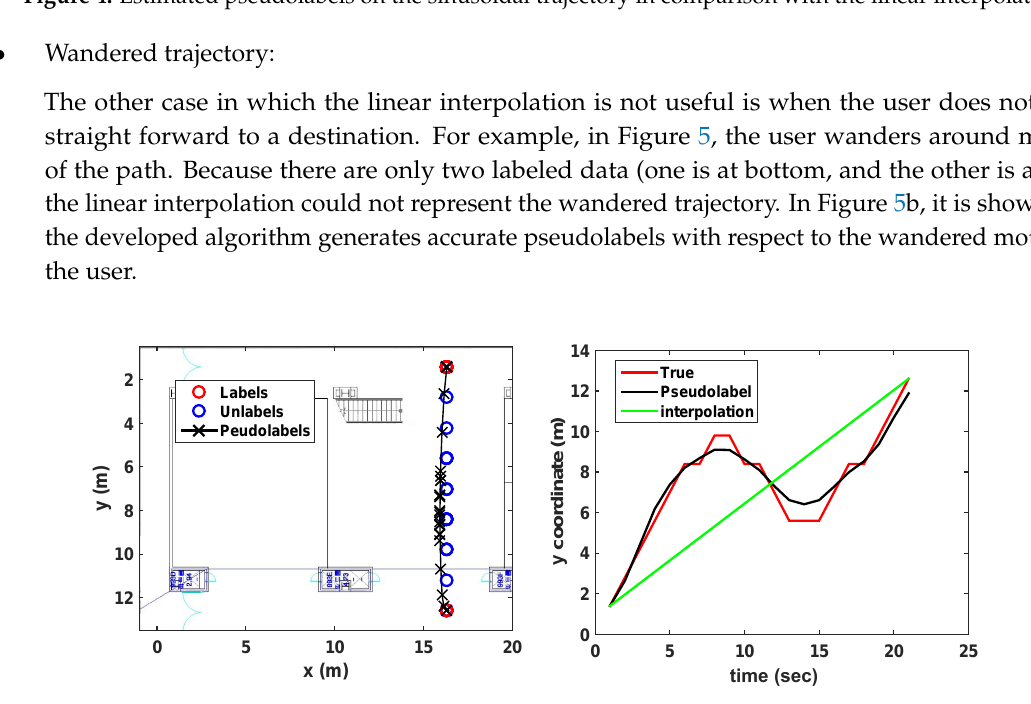
Figure 4. Estimated pseudolabels on the sinusoidal trajectory in comparison with the linear interpolation.